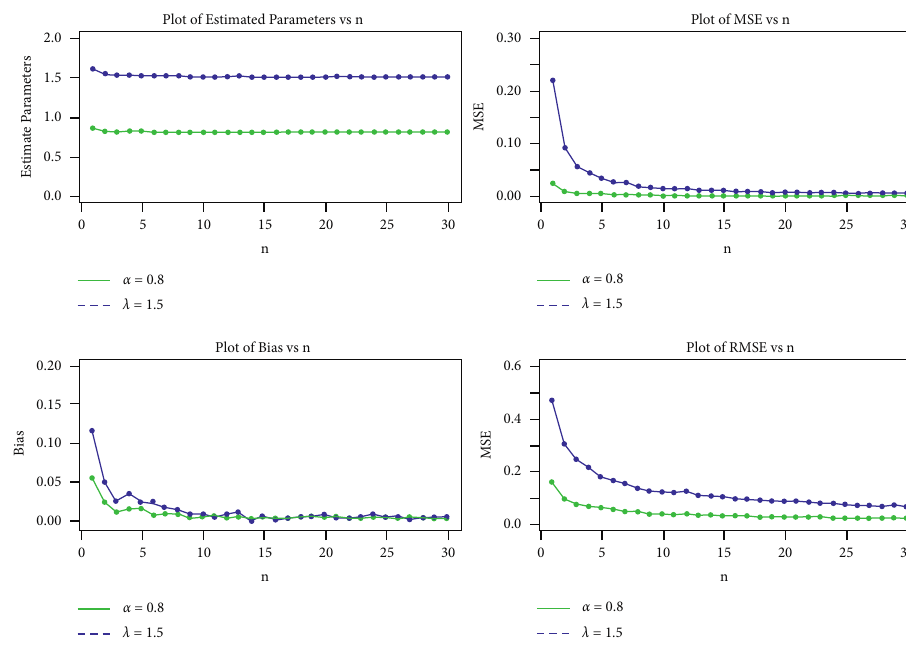
Figure 5: Visual representation of the MC simulation outcomes given in Table